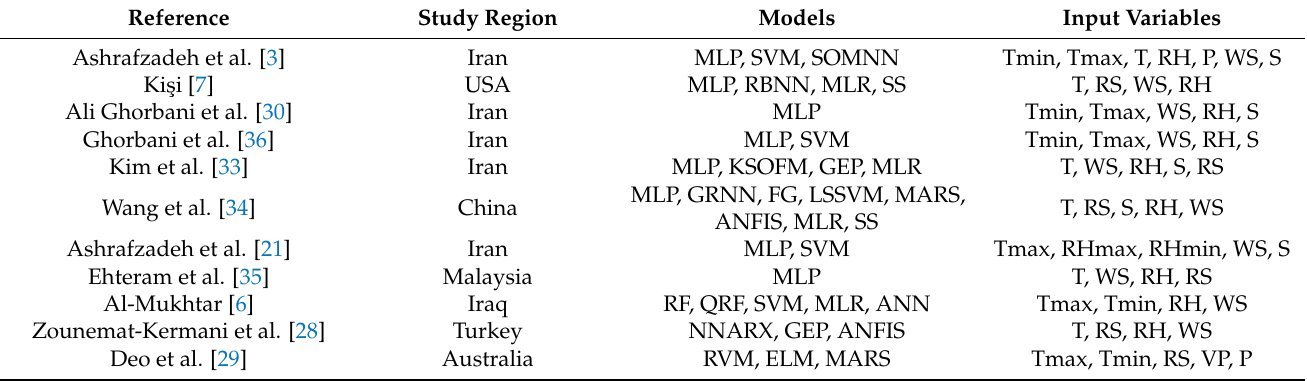
Table A1. Literature review on pan evaporation modeling cases using machine learning